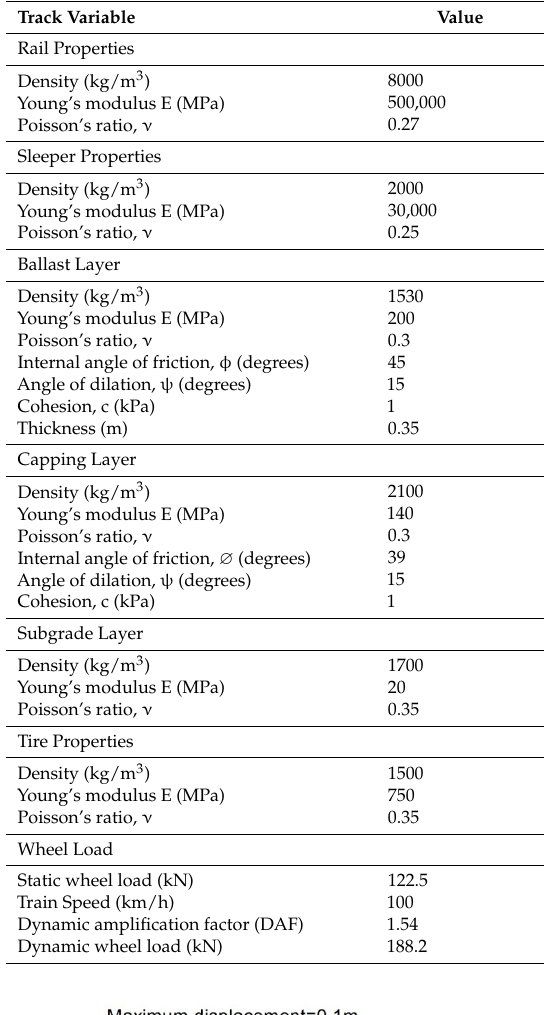
Table 5. Track variable values used in the FEM analysis (adopted from Indraratna et al. [8]).